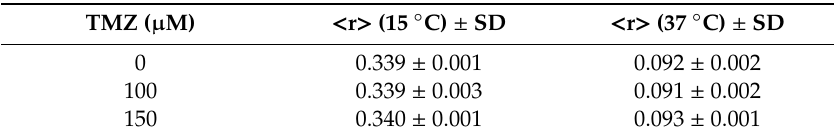
Table 1. 1-6-diphenylhexatriene (DPH) steady state anisotropy values, < r > , in DMPC liposomes at Table 1. 1 ‐ 6 ‐ diphenylhexatriene (DPH) steady state anisotropy values, <r>, in DMPC liposomes at di ff erent TMZ different TMZ concentrations.